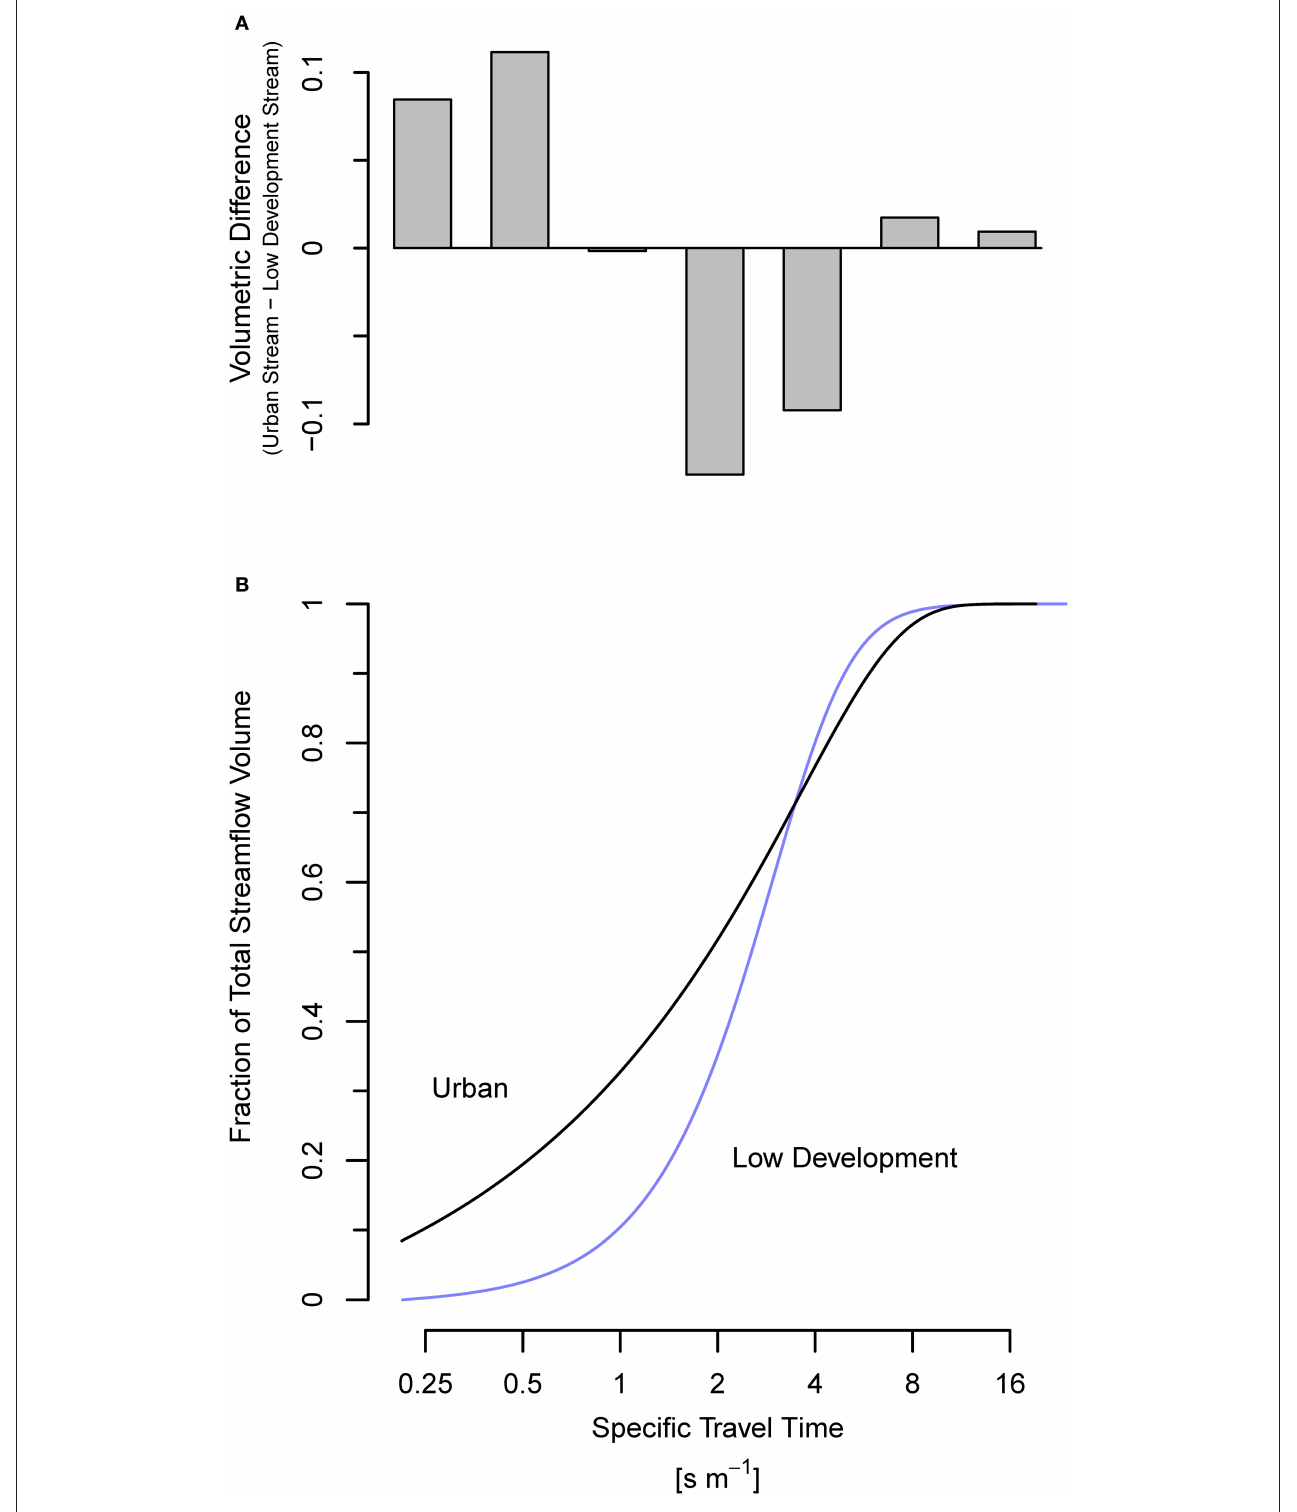
FIGURE 9 | Travel-time distributions for characteristic a low-development and urban stream reach with (A) the marginal difference between the urban and low-development streams in standardized volume [fraction of total] for seven bins of travel time and (B) the cumulative distribution of streamflow by volume for the range of travel times from 0.2 to 20 s/m. Fraction of streamflow volume with travel times < 0.2 s/m is 0% for the low-development stream and 8% for the urban stream.